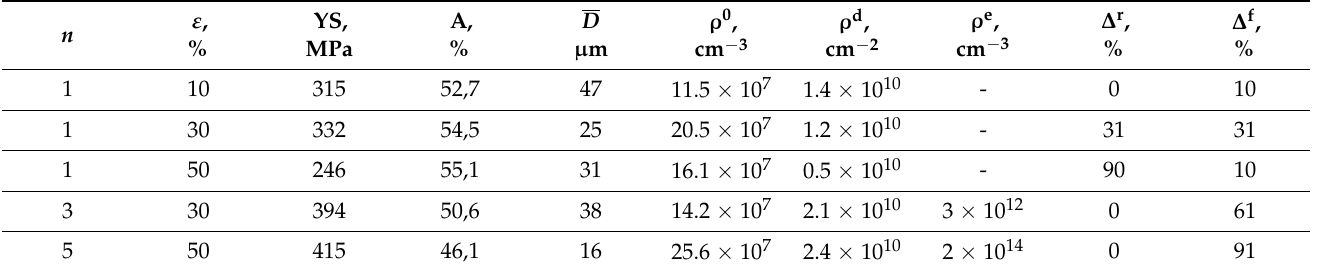
Table 1. Mechanical properties and structure parameters of Cr-Ni-Ti austenitic stainless steel after TMCP with different strain degrees and number of